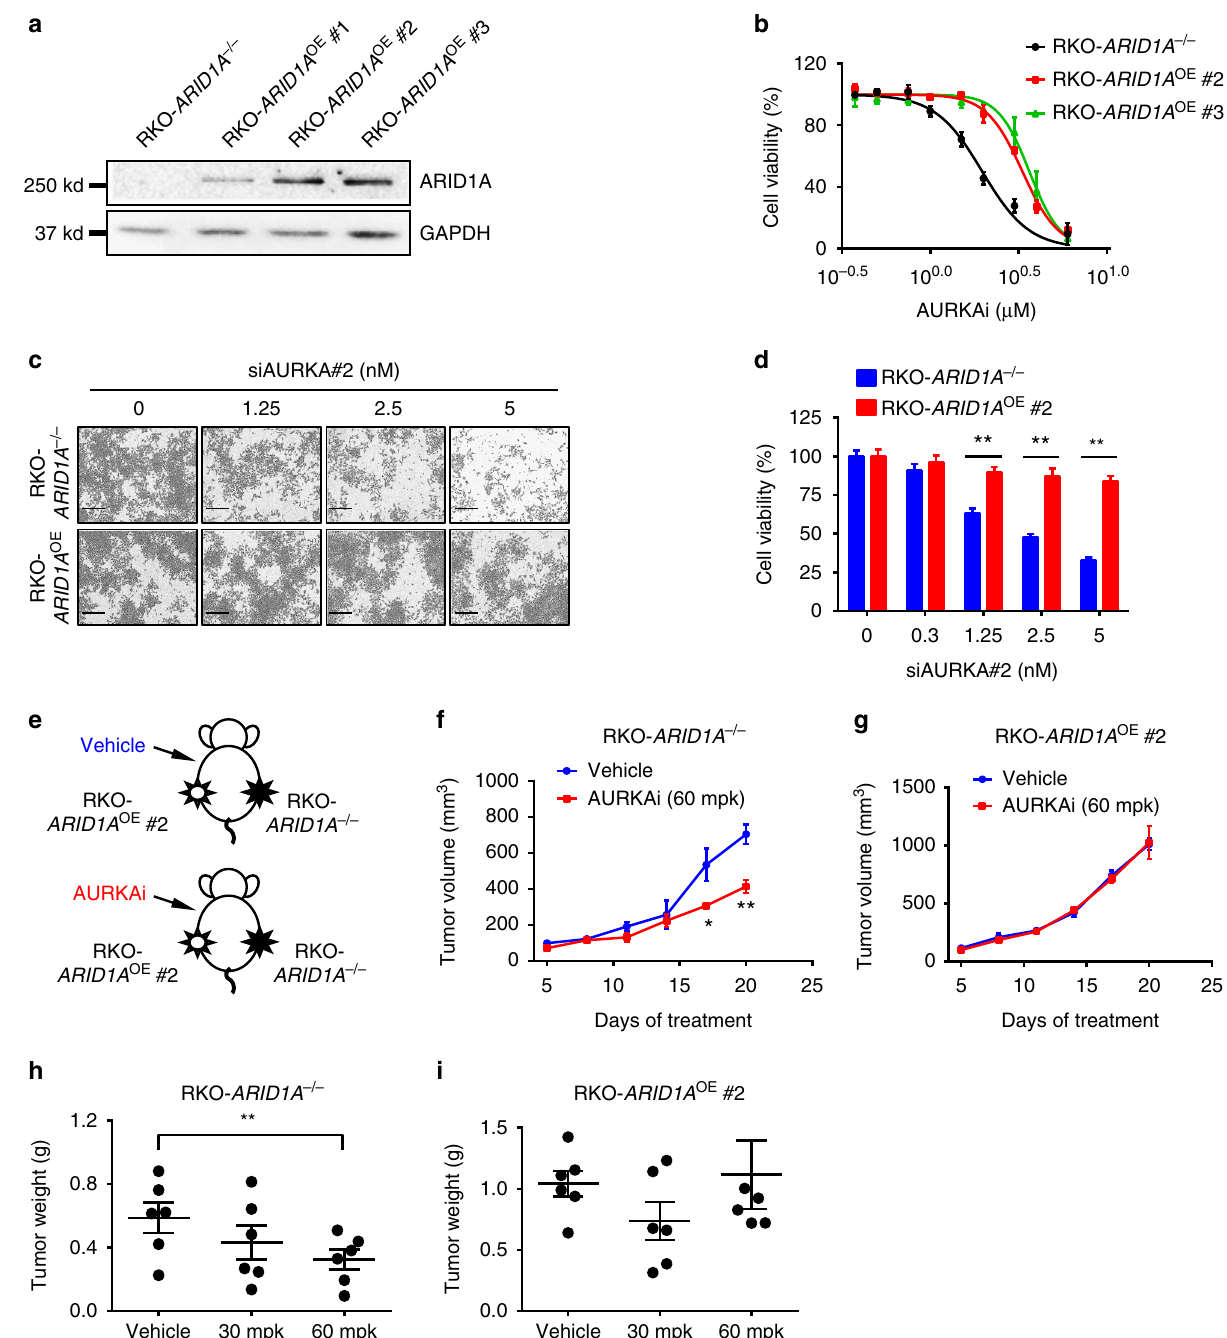
Fig. 3 In vitro and in vivo synthetic lethality in ARID1A − / − RKO cells by AURKA inhibition. a Stable expression of ARID1A in ARID1A − / − RKO cells using a lentiviral transduction. Three selected ARID1A stable clones are shown. b Dose – response curves of ARID1A − / − parental RKO and ARID1A overexpressing (ARID1A OE ) RKO clones treated with AURKAi. Error bars represent s. d . ( n = 6) from three independent experiments. Survival curve of ARID1A − / − versus ARID1A OE cell lines, P value < 0.0001, ANOVA. c Synthetic lethality effect of AURKA siRNA (siAURKA#2) on RKO ARID1A isogenic pair. Representative cell images were taken with IncuCyte ZOOM. Scale bars, 300 µ m. d Integrated cell density was measured with the IncuCyte ZOOM software as a surrogate for cell viability (right panels). Error bars represent s.d. ** P < 0.01, Student ’ s t test. e Schematic illustration of mouse tumor xenograft experiments with RKO ARID1A isogenic cell pair. f , g Tumor growth curve in nude mice bearing ARID1A − / − RKO ( f ) or ARID1A OE RKO clone #2 ( g ) xenografts after injection of vehicle or 60 mg kg − 1 (mpk) AURKAi. Error bars represent s.d. * P < 0.05; ** P < 0.01 between vehicle and AURKAi treatment groups ( n = 6), Student ’ s t test. h , i Wet weight measurement of the tumors isolated from mice bearing ARID1A − / − RKO ( h ) or ARID1A OE RKO clone #2 ( i ) xenografts at 20 days after injection of vehicle, 30 or 60 mpk AURKAi. Error bars represent s.d. ** P < 0.01 between vehicle and 60 mpk AURKAi treatment groups ( n = 6), Student ’ s t